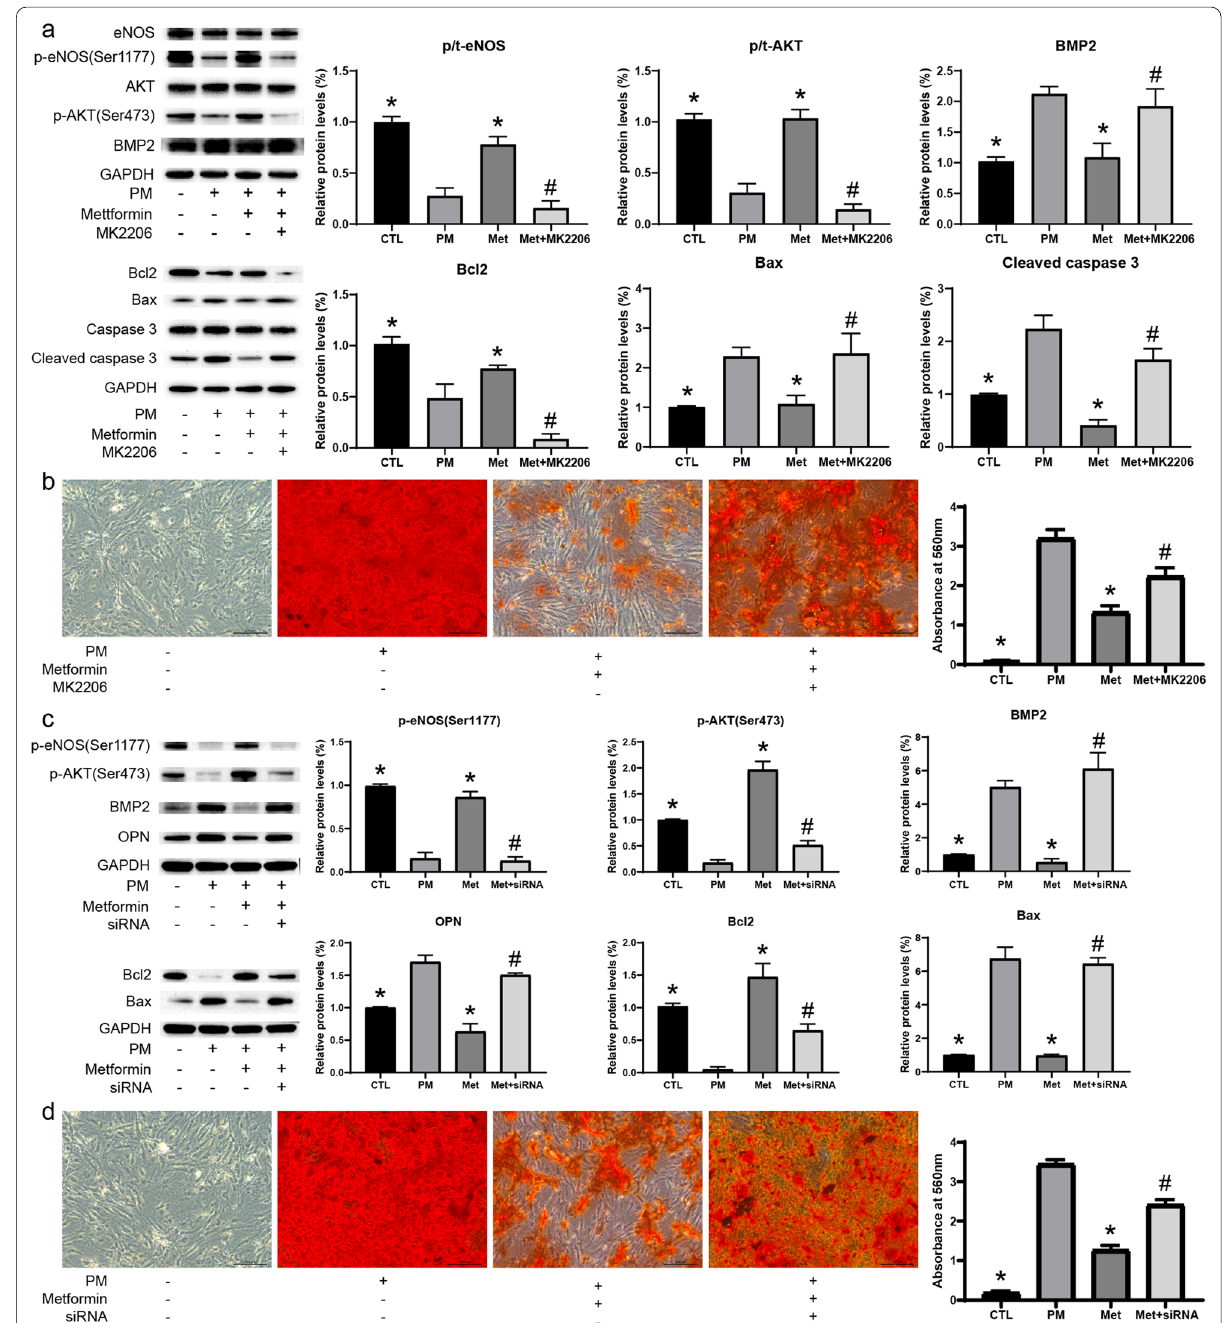
Fig. 7 AKT inhibition ameliorates the anti-calcification and anti-apoptosis effect of metformin on AVICs. a Protein expression levels of the PI3K/ AKT and apoptosis pathway in AVICs after various treatments with metformin (100 μM) and AKT inhibitor (MK2206, 5 μM) for 72 h as determined by WB. c Protein expression levels of the PI3K/AKT and apoptosis pathway in AVICs after various treatments with metformin (100 μM) and AKT siRNA for 72 h as determined by WB; b and d Calcium deposition were detected by ARS Staining after various treatments for 7 days, Scale bar, 200 μm. n 6 per group. CTL control; PM phosphate medium; Met metformin; *p < 0.05 versus PM group; # p < 0.05 versus Met group (one-way ANOVA with = Bonferroni post hoc